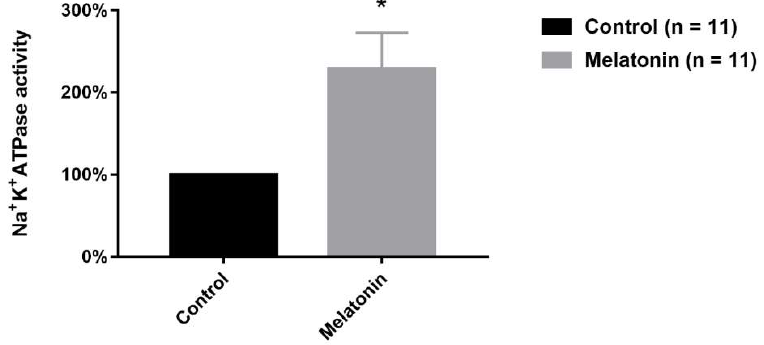
Figure 6. Effect of melatonin (100.0 nM) on Na + K + -ATPase activity. Activities expressed as paired measurements of individual increases related to individual controls normalized as percentage of control activity (means ± SEM). Na + K + -ATPase activity is expressed as nmol (Pi)/µg protein/hour. The symbol * indicates statistically significant difference as compared to control ( p < 0.05, paired Student’s t -test).